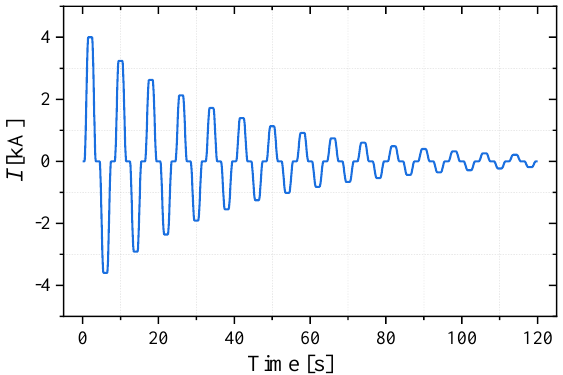
Figure 11. Current waveform of cable.